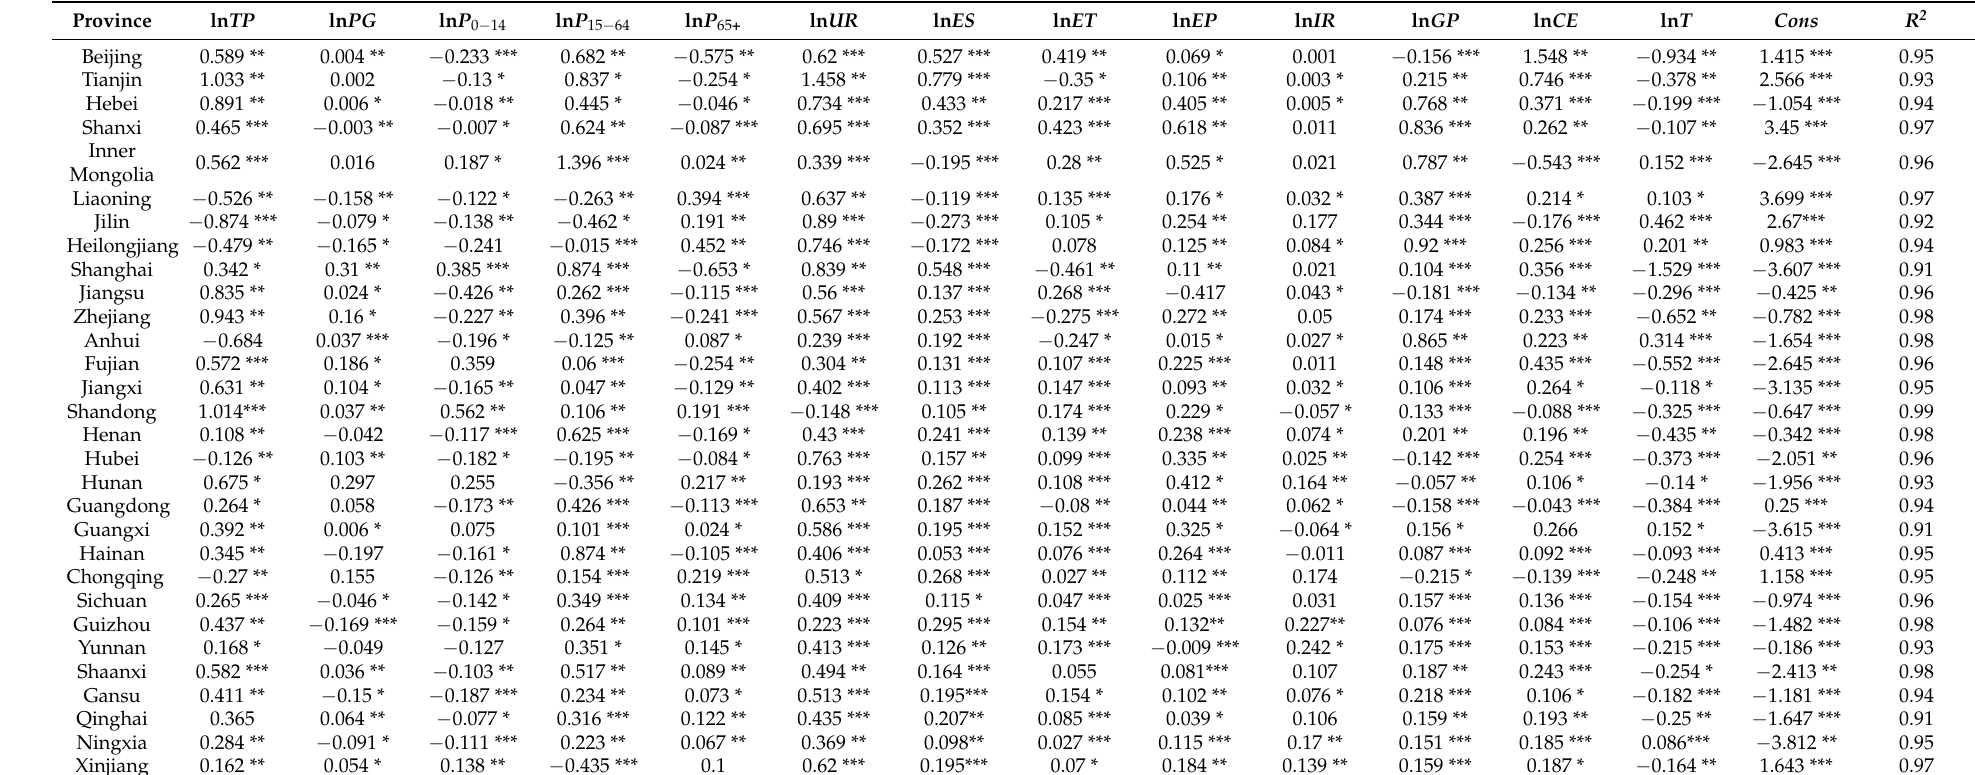
Table 6. Extended STIRPAT model results for 30 Chinese